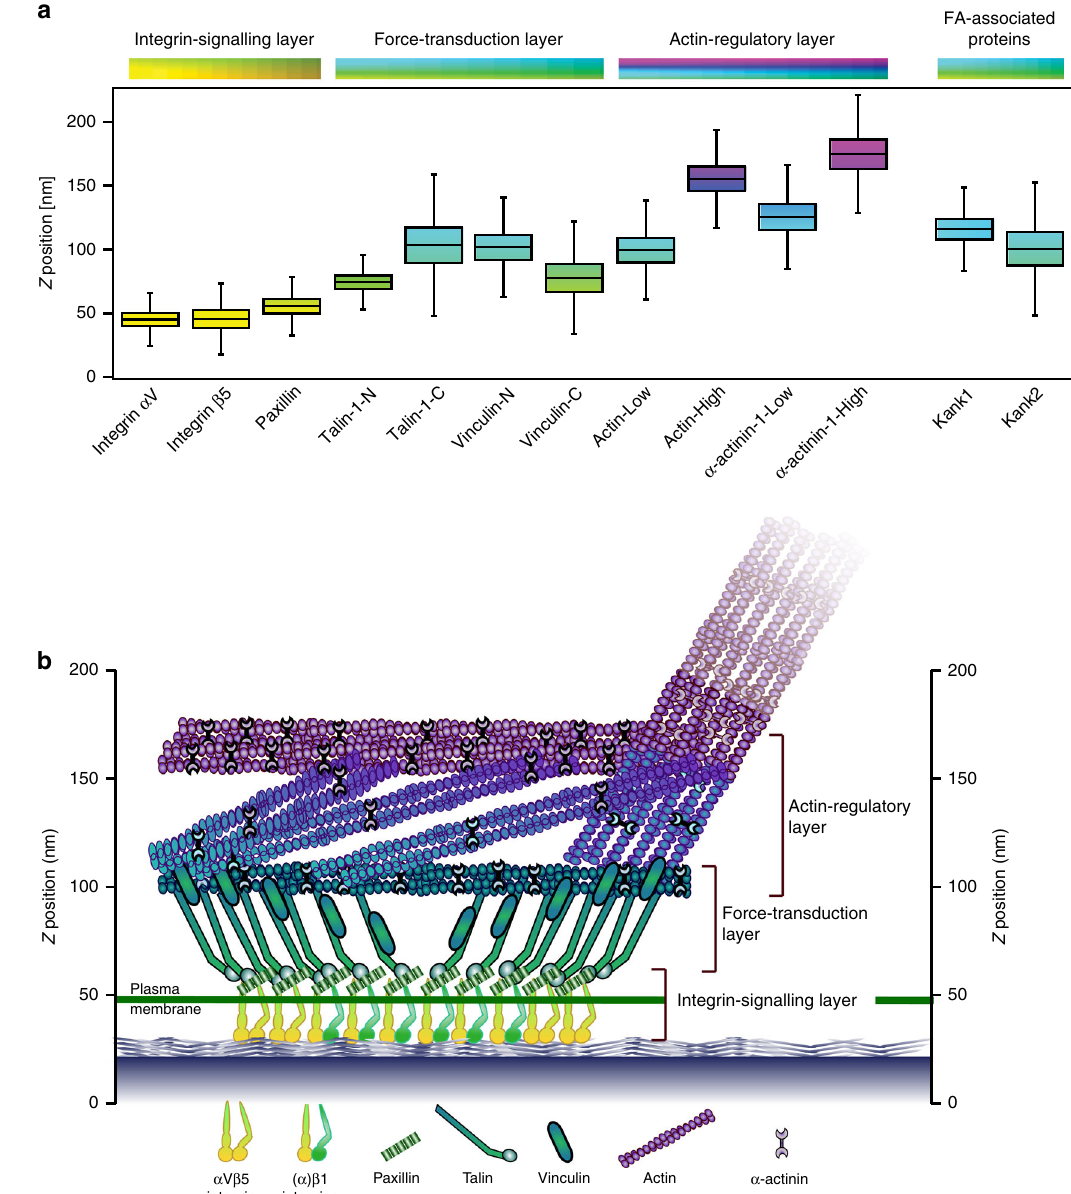
Fig. 7 Overall vertical strati fi cation of cornerstone FA. a Z positioning ( Z centre ) of α V and β 5 integrins, paxillin, vinculin, talin-1, actin, α -actinin-1, kank1 and kank2 in cornerstone adhesions. Letters – N and – C denote the location of the tag while “ low ” and “ high ” denote separate peaks in the distribution of the same protein. Boxes display the median, plus the 1st and 3rd quartiles (IQR: 25th – 75th percentile). Whiskers correspond to the median± 1.5 × IQR. b Schematic model of the 3D architecture of hPSC cornerstone adhesions. The lateral and vertical positioning of each protein are based on the data presented here. This model does not depict protein stoichiometry. Source data are provided as a Source Data fi